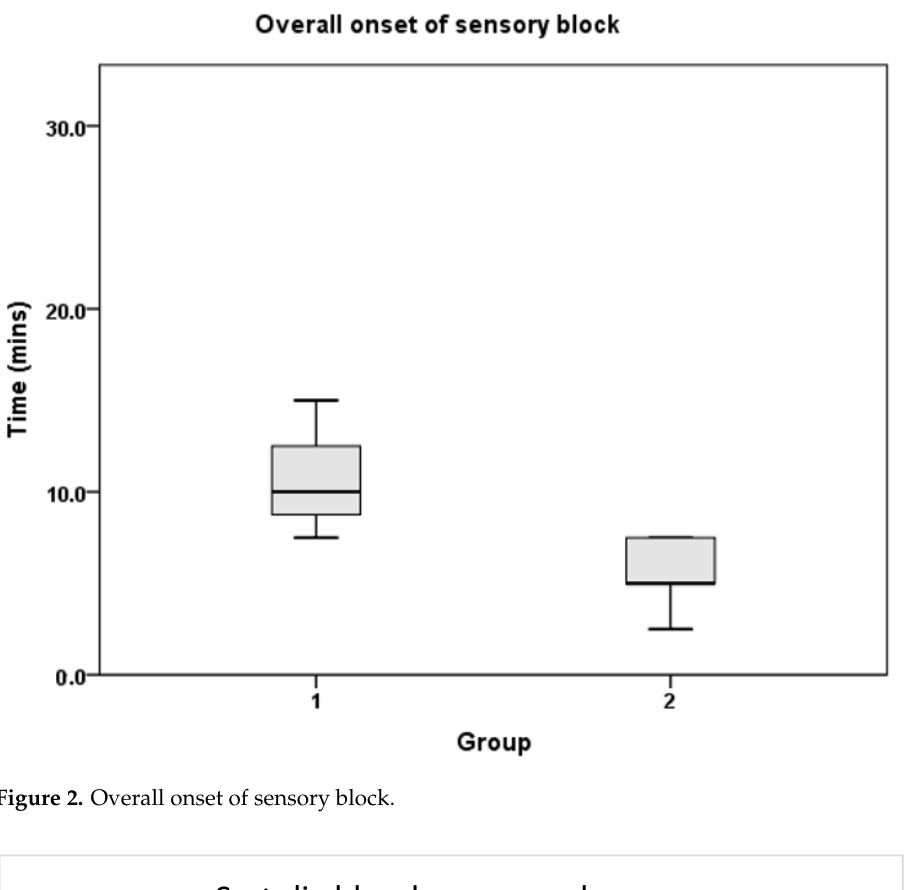
Table 4. Sensory and motor block duration (min).